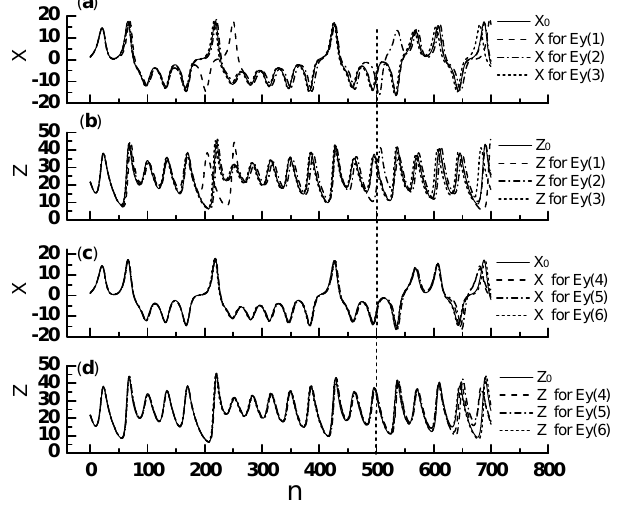
Fig. 5. Error correction based on the third component L z (x,y,z) using EM. (a) and (b) are the fitting and prediction data of the corrected models using the error function E ( 1 ) z ,E ( 2 ) z ,E ( 3 ) z , respectively. (c) and (d) are the same as (a) and (b) , but for E ( 4 ) z ,E ( 5 ) z ,E ( 6 ) z ,